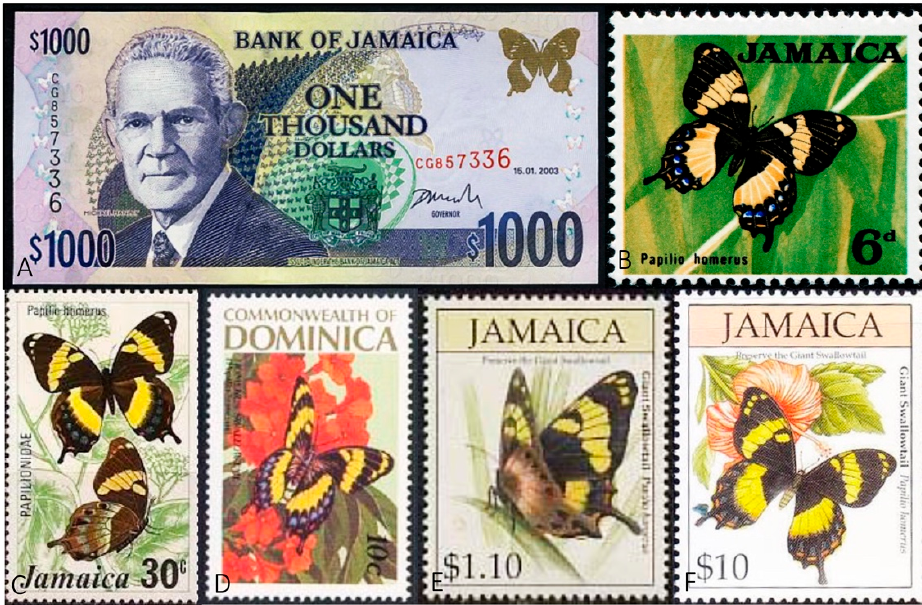
Figure 2. Printings and postage stamps of Papilio homerus that contribute to its status as a flagship species. ( A ) The Jamaican $1000 bill features P. homerus in the upper-right corner. Representative stamps issued in 1964 ( B ), 1975 ( C ), 1989 ( D ), and 1994 ( E , F ) that feature P. homerus .